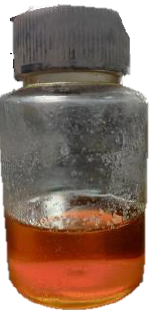
Figure 2. Modified kitchen waste oil trap.